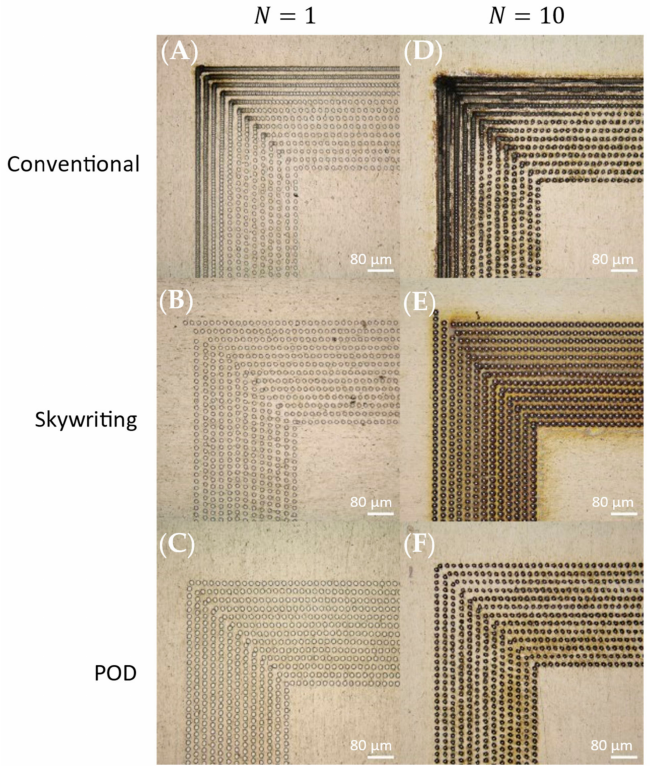
Figure 2. Comparison of scanning strategies by effects in corners of scanning lines—ablation craters in stainless steel for a set of different scanning velocities. The scanning speeds used were v = {0.25;0.50;0.75;1.0;1.5;2.0;2.5;3.0;5.0;7.5;10;15;20} m/s, with the lowest speed positioned innermost and increasing outwards. Scale bars are equal to 80 µ m.